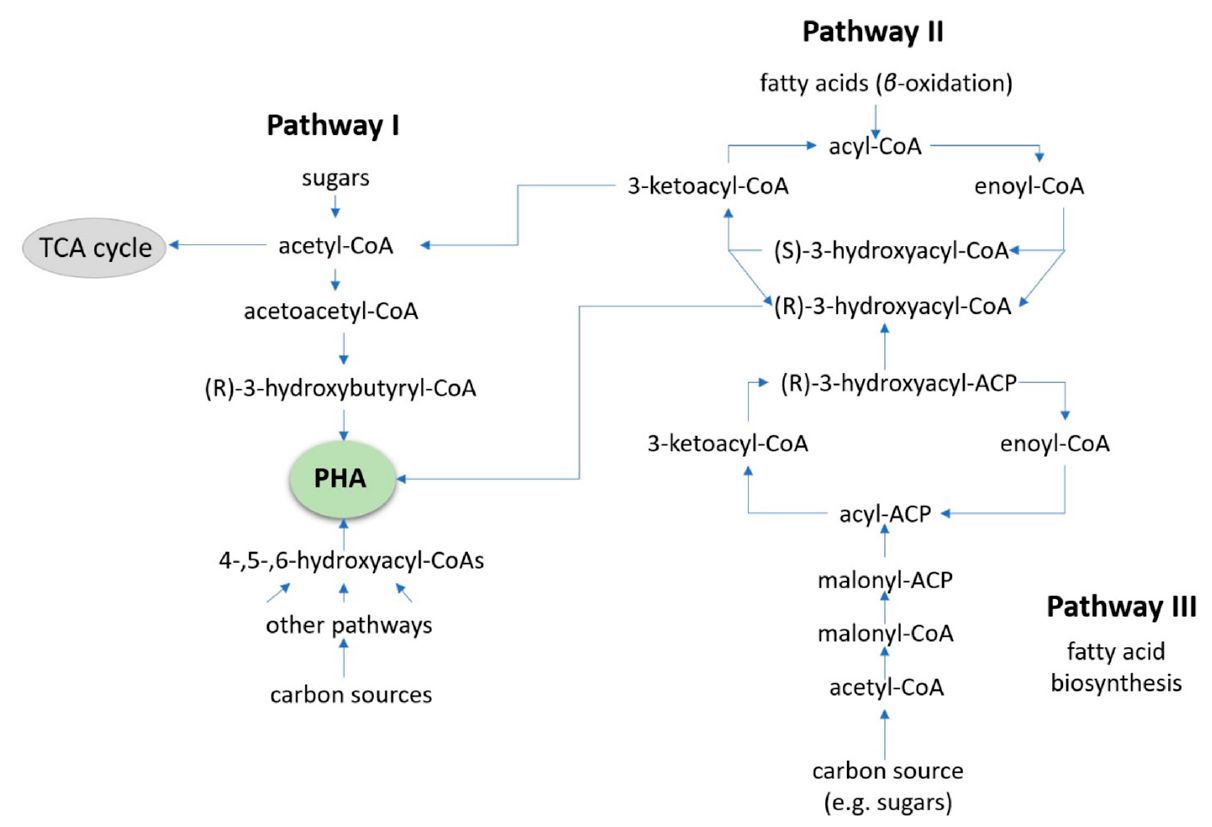
Figure 6. The combined pathways I, II, and III used by C. necator for PHA bioconversion. Similar biochemical pathways would be expected for other bacterial species capable of PHA synthesis where oxidized PS, PE, or PP waste plastic is treated as a fatty acid.